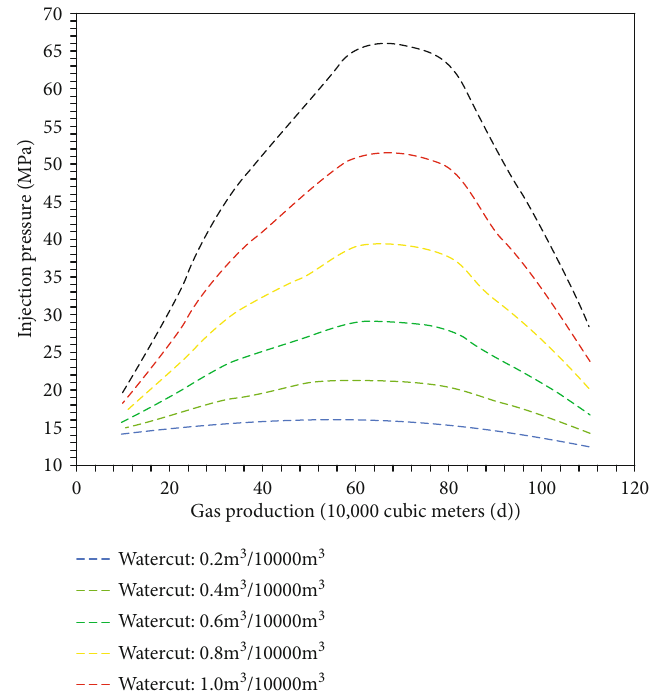
Figure 11: Ethylene glycol injection pressure